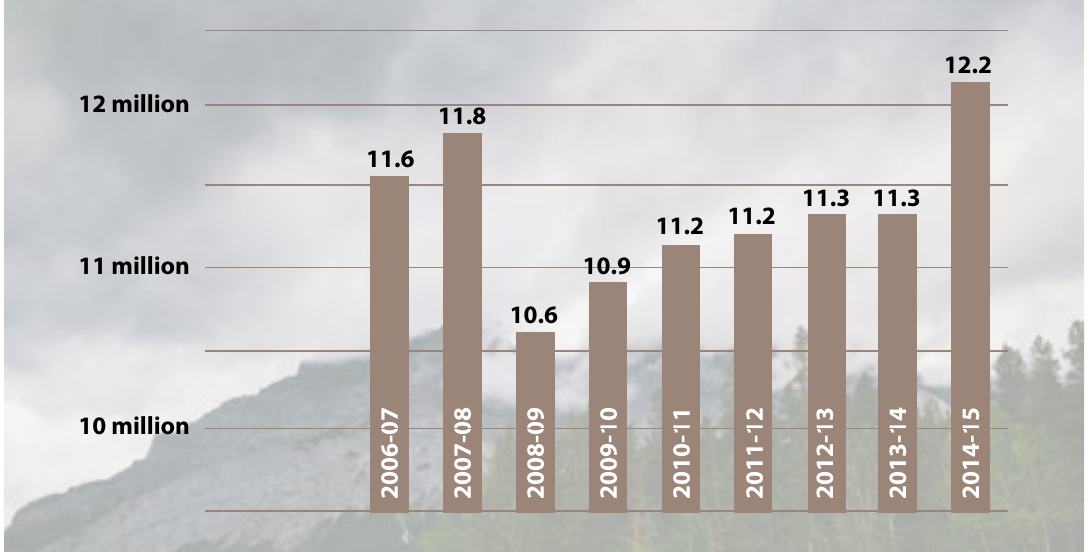
Figure 1. National Park visitation, 2006-07 to 2014-15 12